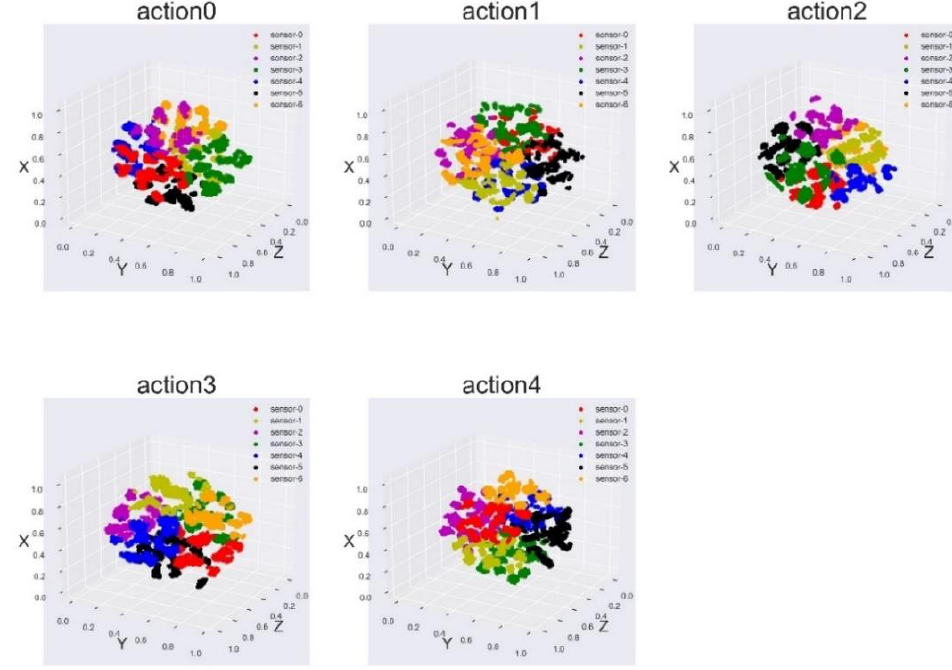
Figure 19. Visualization of local feature vectors of table tennis actions in each category.